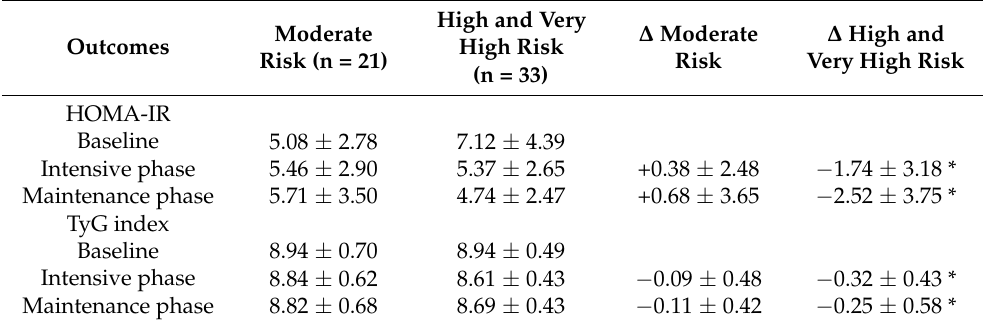
Table 5. Comparison of IR markers in the completer subjects with moderate risk or high and very high risk of diabetes by the FINDRISC